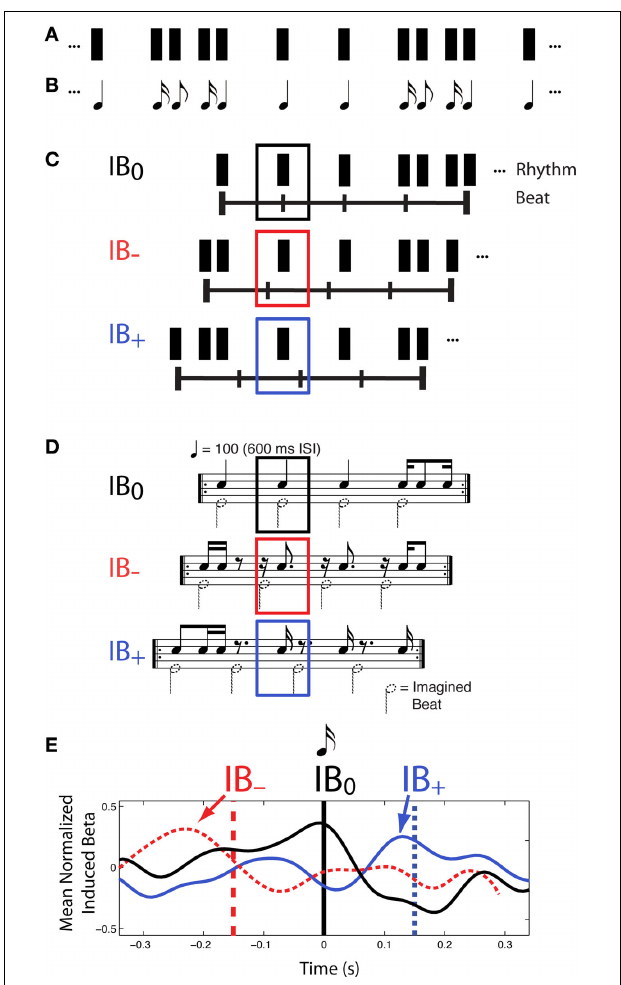
FIGURE 3 | Patterns of induced beta-band neural activity as a function of imagined beat location in a syncopated rhythm, adapted from Iversen et al. (2009). (A) Constant rhythmic pattern where individual notes are indicated by black rectangles. (B) Music notation of the same rhythm pattern. (C) On different trials, participants mentally organized the perceived beat structure of a syncopated rhythm so that all beats fell on sounded tones (condition IB0) or some beats fell on silent positions just before (IB − ) or after (IB + ) sounded tones, (IB = Imagined Beat). The horizontal line with vertical tick marks indicates the timing of the imagined beats, and the rectangles above indicate the repeating rhythmic unit for each beat organization. (D) Music notation of three beat structures and associated rhythms shown in (C) . Black notes show sounded tones, while notes with dotted note heads show imagined beats. The sounded-tone pattern is physically identical in all three conditions, but is psychologically distinct depending on where one feels the beat. In both (C,D) black, red and blue squares indicate the analysis window for MEG data, which is centered on the same tone. (E) Patterns of induced beta-band neural activity for beats on actual tones (marked by the vertical black line at 0ms) vs. beats on silent positions just before (red) or after (blue) sounded tones. For the beat-at-silent-position conditions, the vertical dashed lines show the location of the imagined beats, relative to the sounded tone at time 0, and the grand mean normalized fluctuation of induced beta-band activity shows a peak of power that reflects the timing of the imagined beat (arrows), not the auditory input. Note how in all three conditions, the power of the induced beta-band signal rises in anticipation of the time of the beat, and sharply decreases around the time of the beat. Beta-band fluctuation was computed by subtracting the mean over the entire interval ( − 300 to